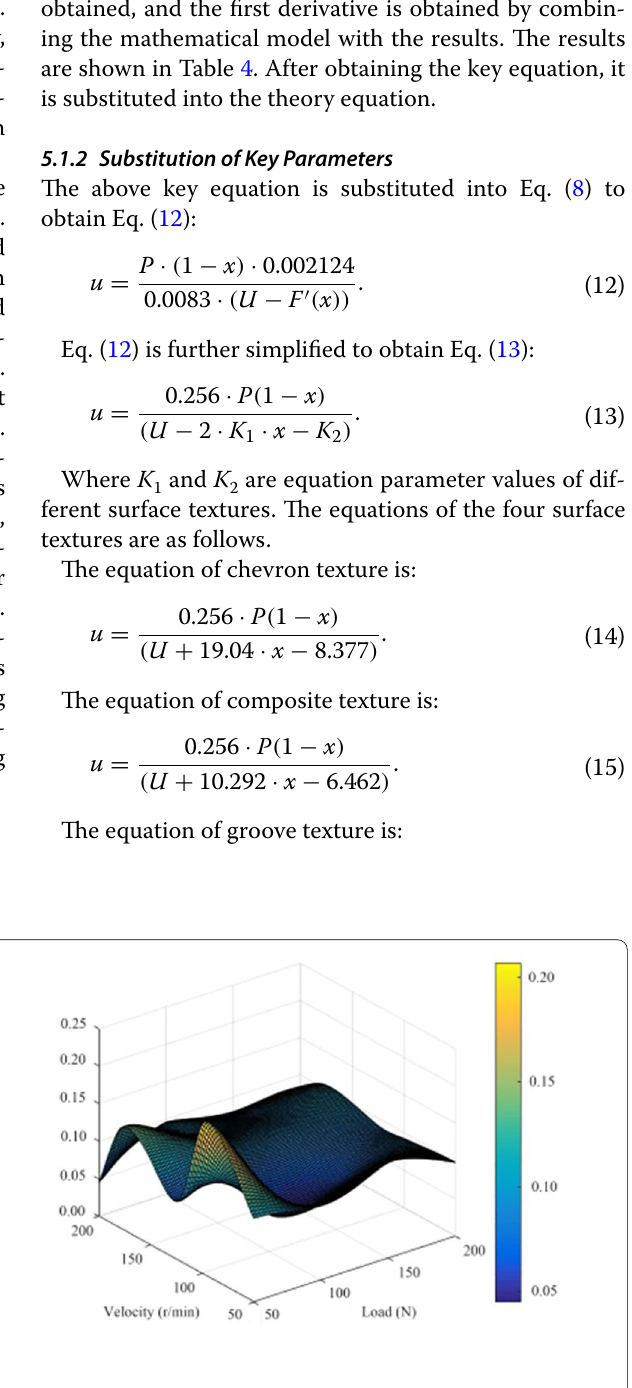
Figure 12 Experimental results of circular